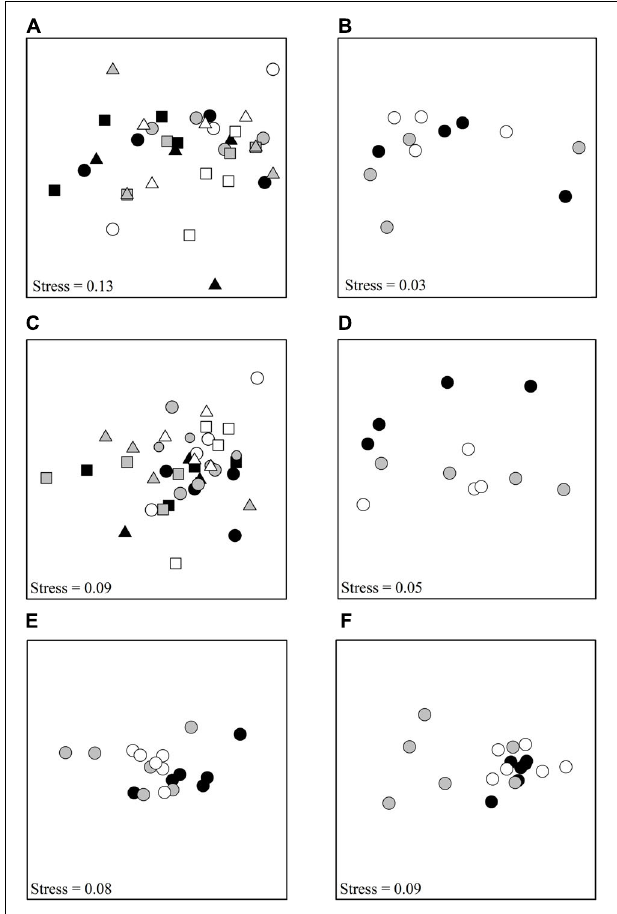
FIGURE 1 | nMDS plots showing differences among treatments, (A) Tambourine Bay macrofauna after 2 weeks, (B) Gore Creek macrofauna after 2 weeks, (C) Tambourine Bay properties of sediment after 2 weeks, (D) Gore Creek properties of sediment after 2 weeks, (E) Tambourine Bay macrofauna after 3 months, (F) Tambourine Bay properties of sediment after 3 months. For panels (A,C) , each point represents 1 plot; black – heavily shaded plots with black roofs, gray – lightly shaded plots with clear roofs, white – unshaded control plots; circles – with nutrients, square – procedural control (buried plastic ring), triangle – no additional nutrients. For the rest of the panels, each point represents 1 plot; black – heavily shaded plots with black roofs, gray – lightly shaded plots with clear roofs, white – unshaded control